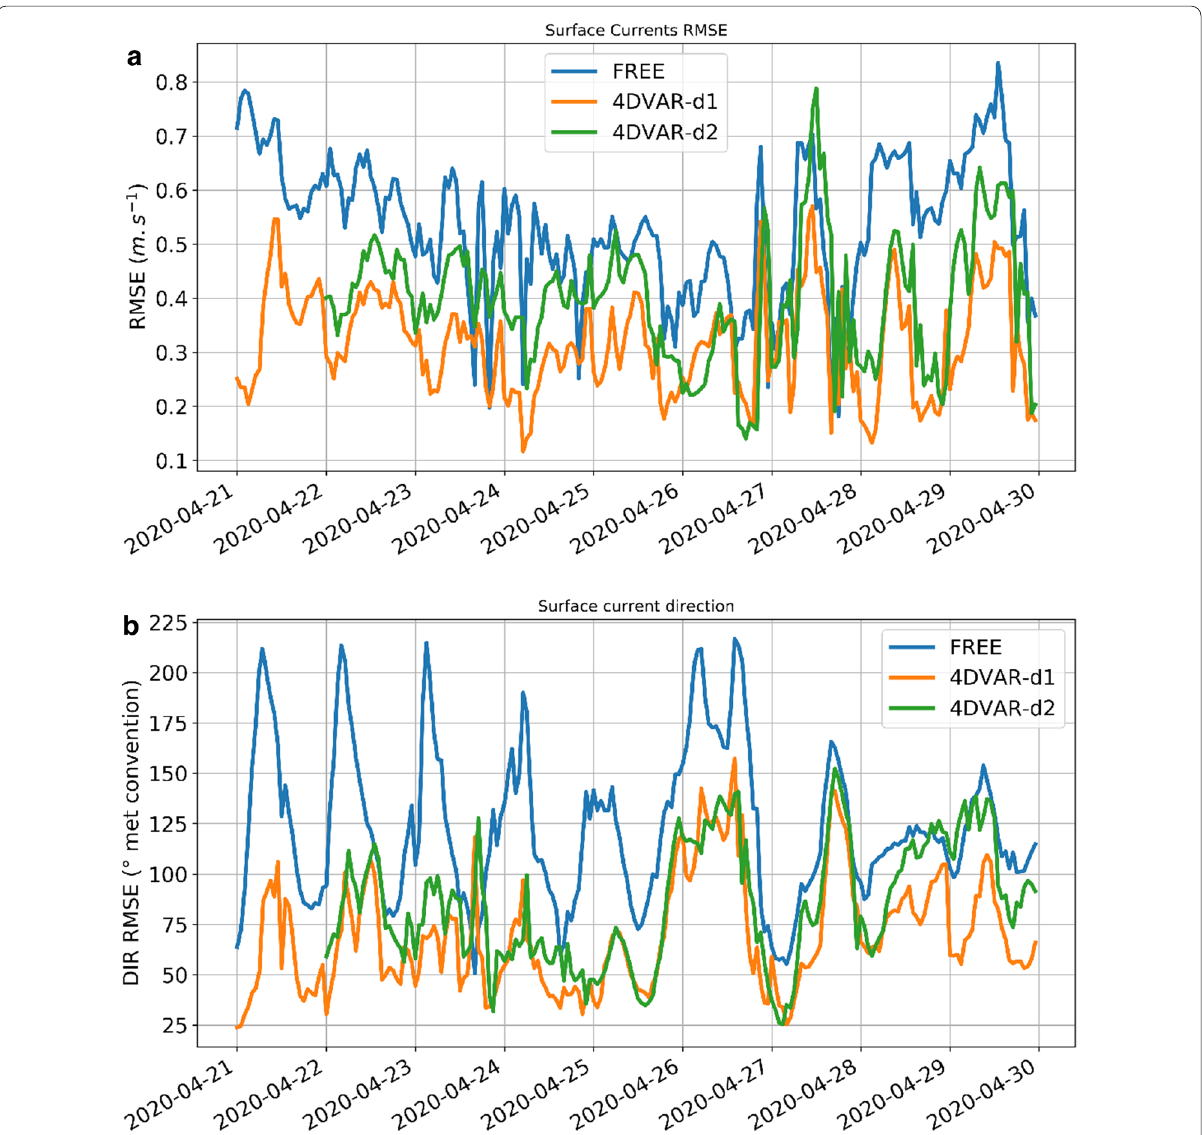
Fig. 7 FREE and 4DVAR surface velocities ( a ) and direction ( b ) RMSE (against HF radar). 4DVAR-d1 and 4DVAR-d2 represent the first and the second day of forecast